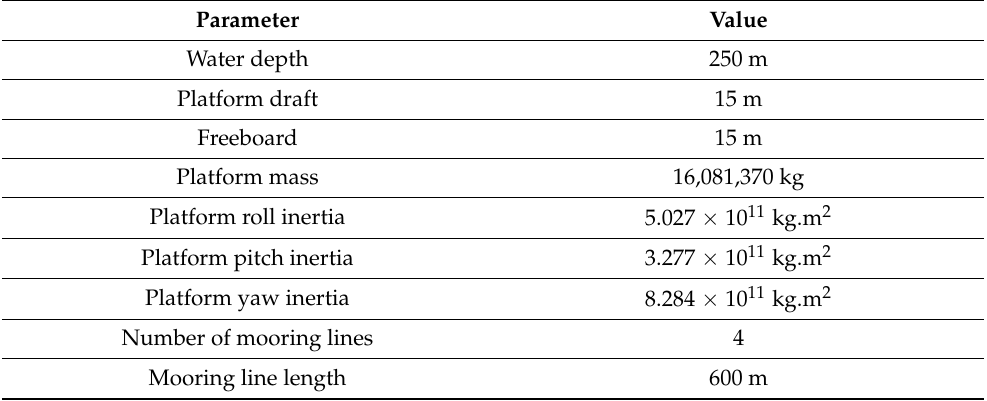
Table 5. Properties of the platform configuration.